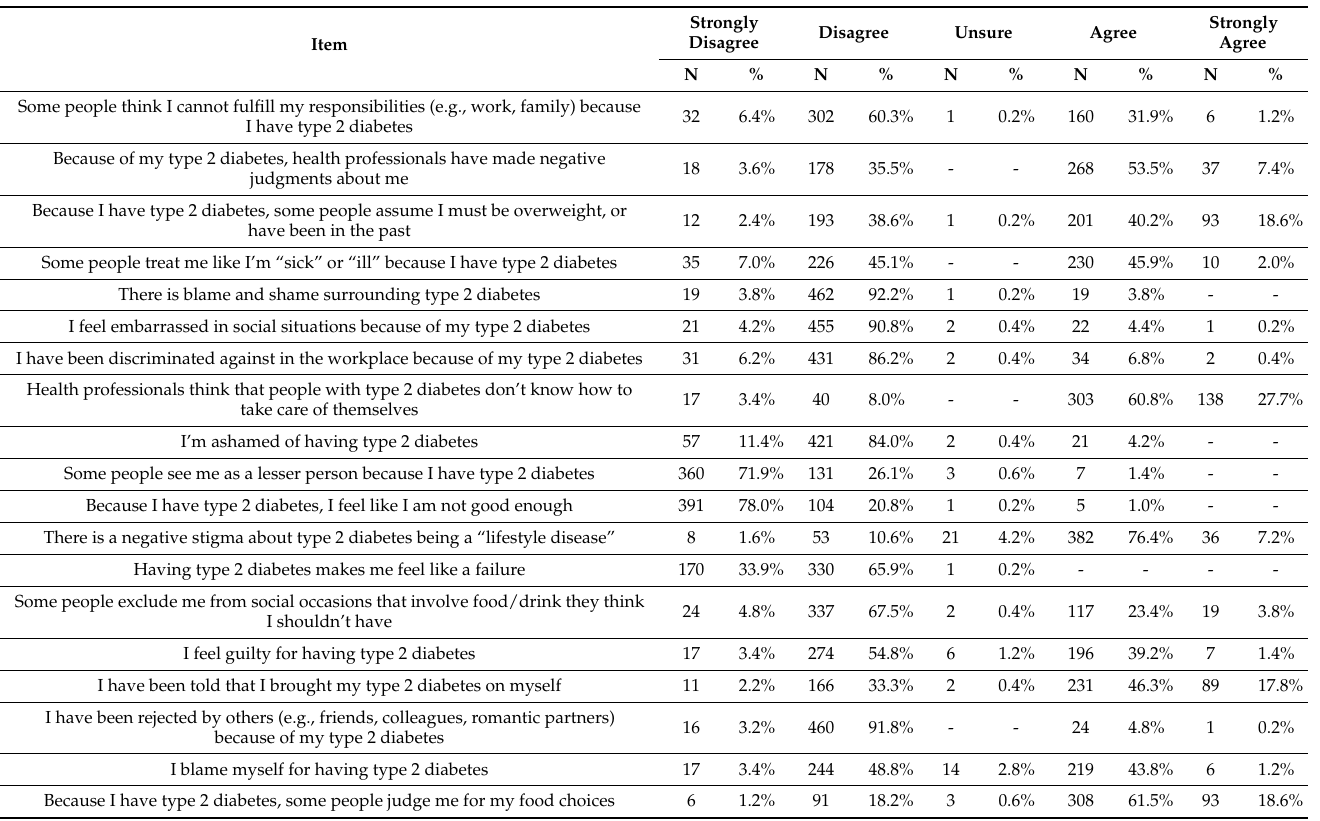
Table 3. Item analysis for